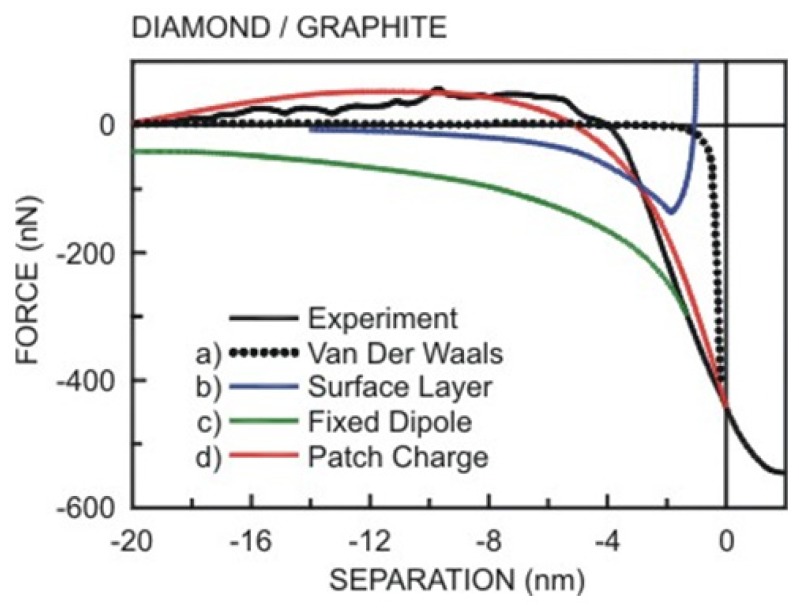
Attractive force curve for diamond-graphite (kc = 260 Nm−1, Rt = 300 nm) with various theoretical fittings: (a) vdW; (b) surface layer of dielectric material; (c) fixed dipole; and (d) patch charge. The values used for the vdW interactions were Rt = 300 nm and A = 2.5 × 10−19 J. The thickness of the surface layer was 1nm, with a tip radius of 30 μm, A = 2.5 × 10−19 J and ΔA = 0.2. For the fixed dipole curve, the thickness of the dipole layers was 1nm, the dipole moments = 1.4 Debye, the volume density of the dipoles was 3.0 × 1028 m−3 and the tip radius was 300 nm (Reproduced by permission of IOP Publishing Ltd. [94]).